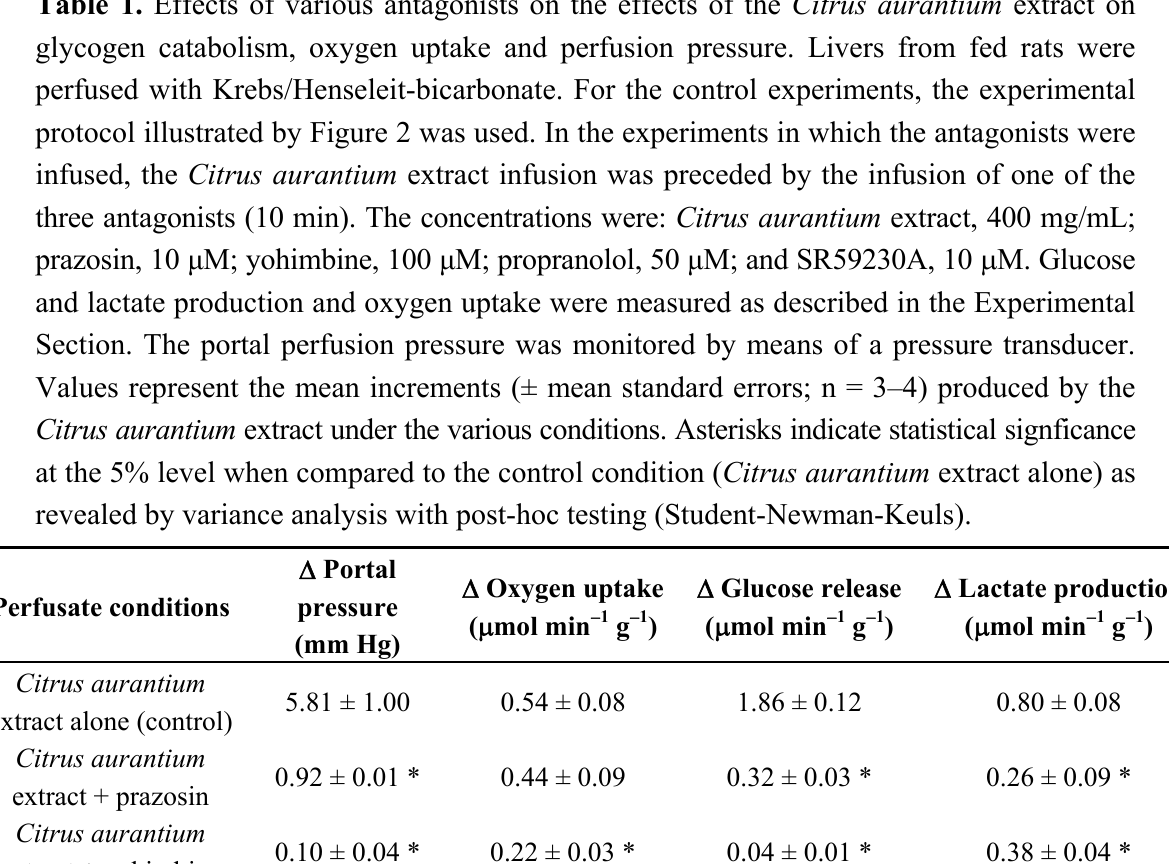
Table 1. Effects of various antagonists on the effects of the Citrus aurantium extract on glycogen catabolism, oxygen uptake and perfusion pressure. Livers from fed rats were perfused with Krebs/Henseleit-bicarbonate. For the control experiments, the experimental